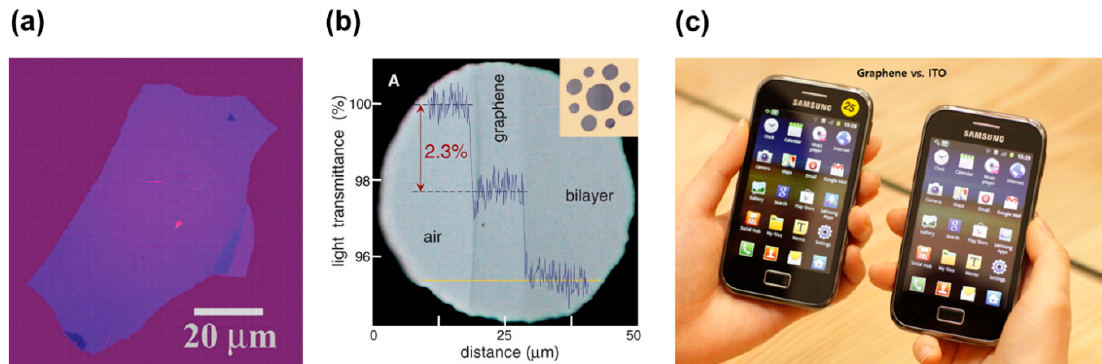
Figure 2. ( a ) Photograph of a large multilayer graphene flake with a thickness of ~3 nm on top of an oxidized Si wafer. Reprinted with permission from ref. [9]. Copyright (2004) American Association for the Advancement of Science. ( b ) Photograph of an aperture partially covered by graphene and its bilayer. Reprinted with permission from ref. [10]. Copyright (2008) American Association for the Advancement of Science. ( c ) Photograph of a graphene-based mobile electronic device compared to a traditional transparent material-based device. Reprinted with permission from ref. [19]. Copyright (2014) American Chemical Society.